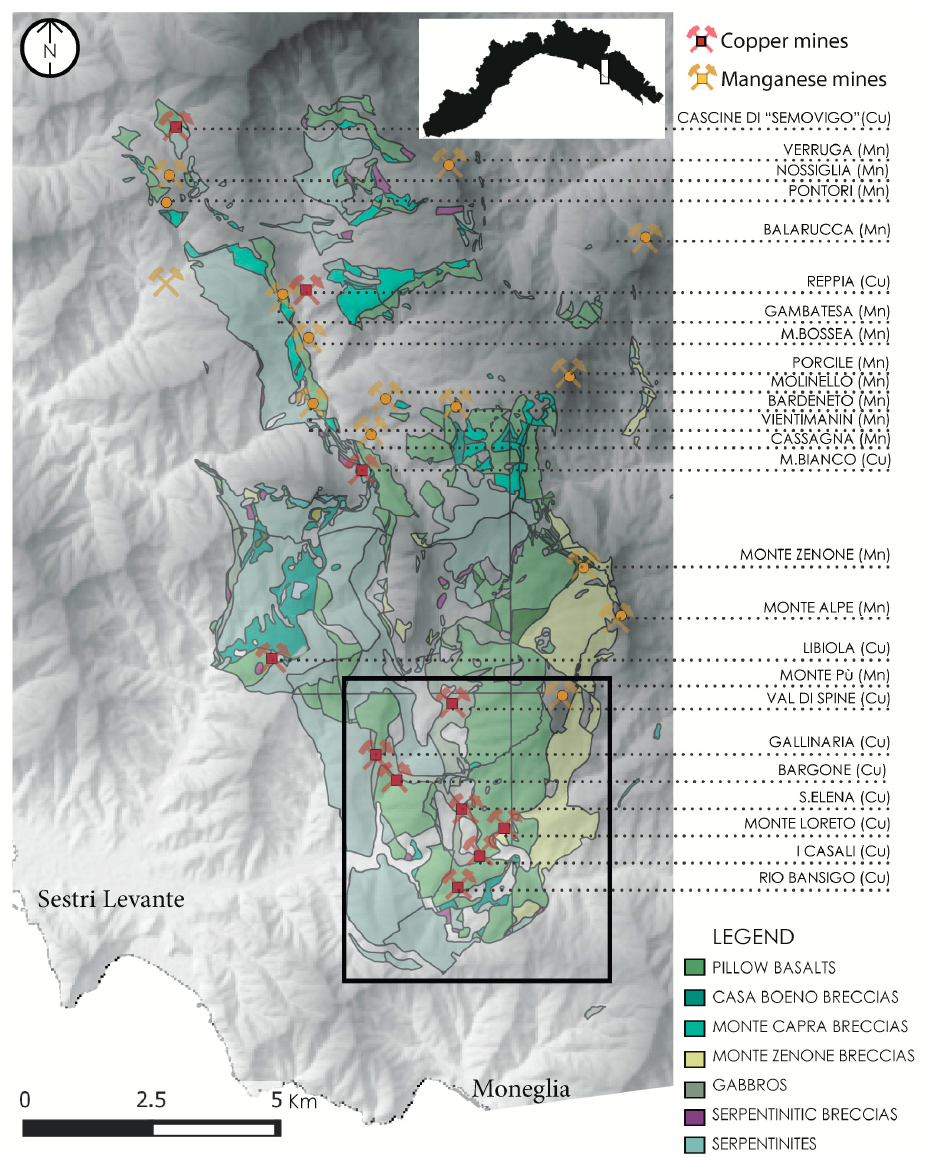
Figure 2 . Location of the main abandoned mines in ophiolites of eastern Liguria. The black rectangle indicates the studied area (Val Petronio copper sulfide mines). Geological map supplied as Open Data by the Liguria Regional Government [42]